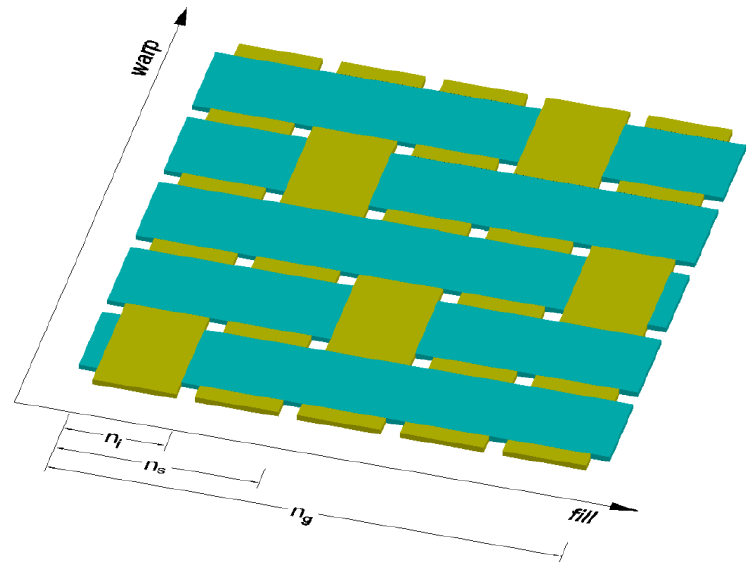
Figure 1. The parameters defining repetitive unit cell for satin 5/2/1 reinforced composite.